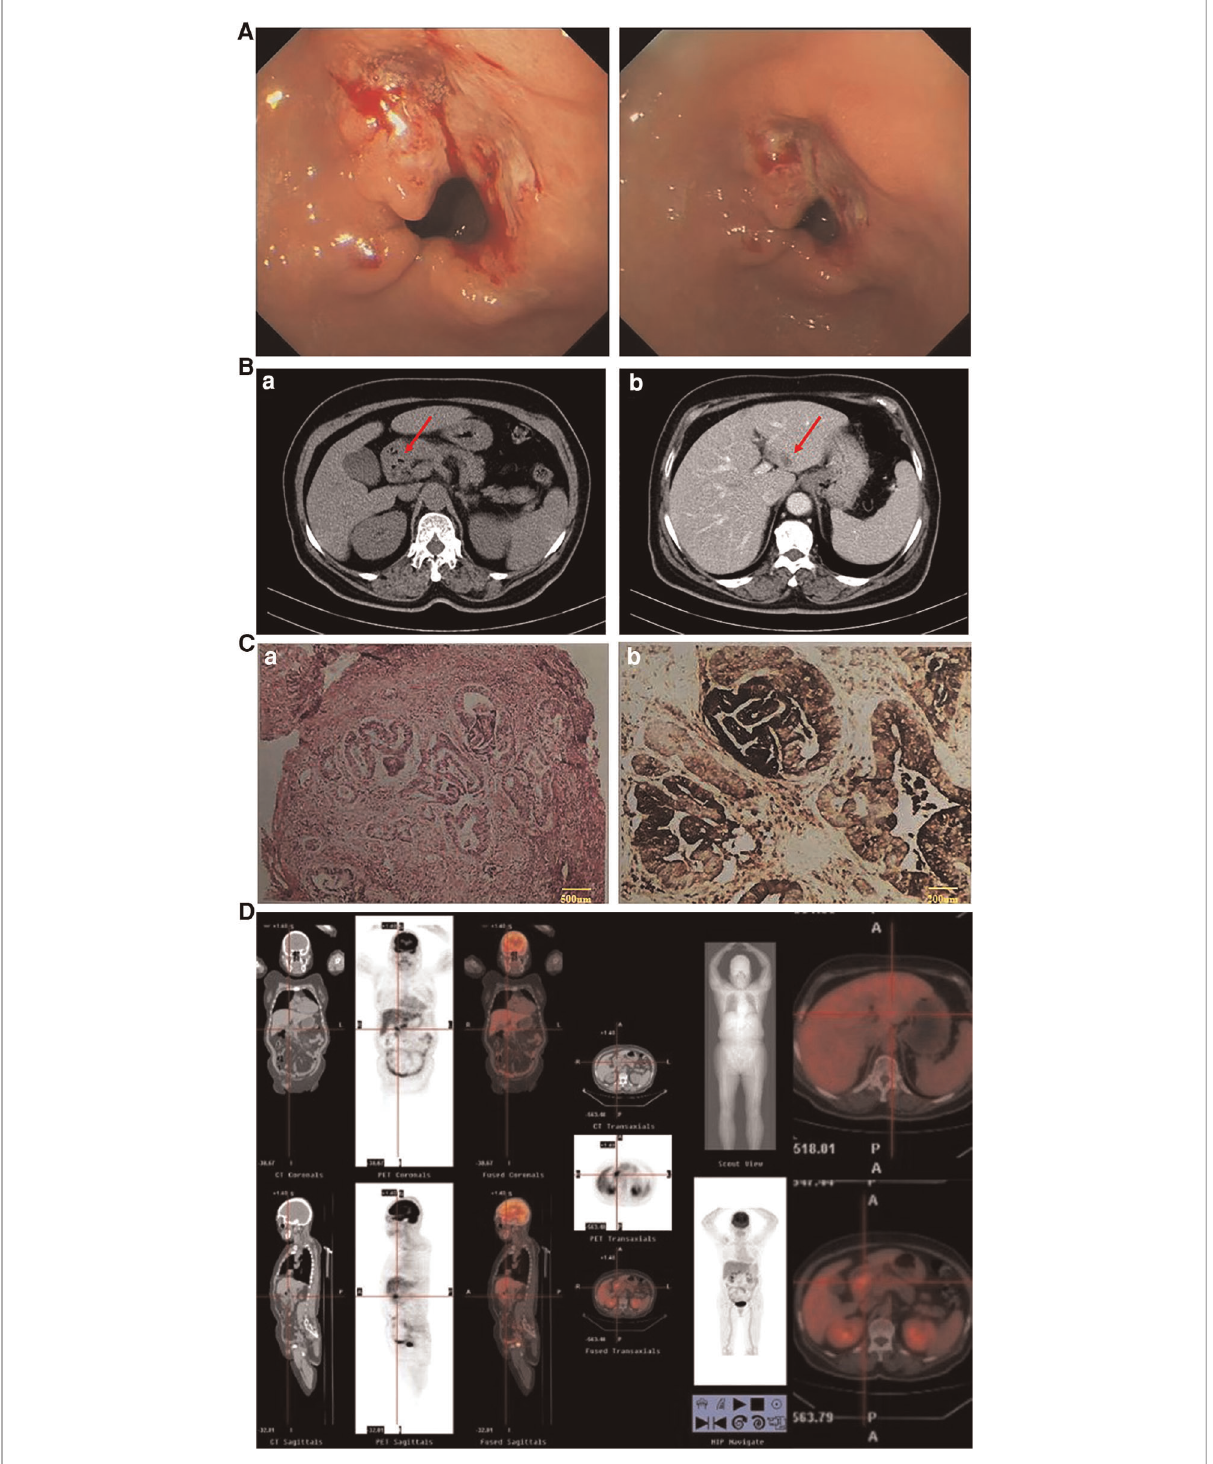
FIGURE 1 ( A ) Gastroscopy (April 1, 2020): gastric antrum ulcer. ( B ) CT (April 1, 2020): (a) Gastric antrum tumor; (b) Abnormal low density of left lateral lobe of the liver, considering metastasis. ( C ) Results of endoscopic biopsy: (a) HE staining; (b) AFP staining. (Gastric antrum) Moderately to poorly differentiated hepatoid adenocarcinoma. Immunopathology: AFP(+), HER-2(+), Ki-67(40%), PD-L1(22C3)( − ), PD-1( − ), CD4(+), CD8(+), MLH1(+), PMS2(+), MSH6(+), MSH2(+). ( D ) PET-CT examination: The masses of gastric antrum and left liver were